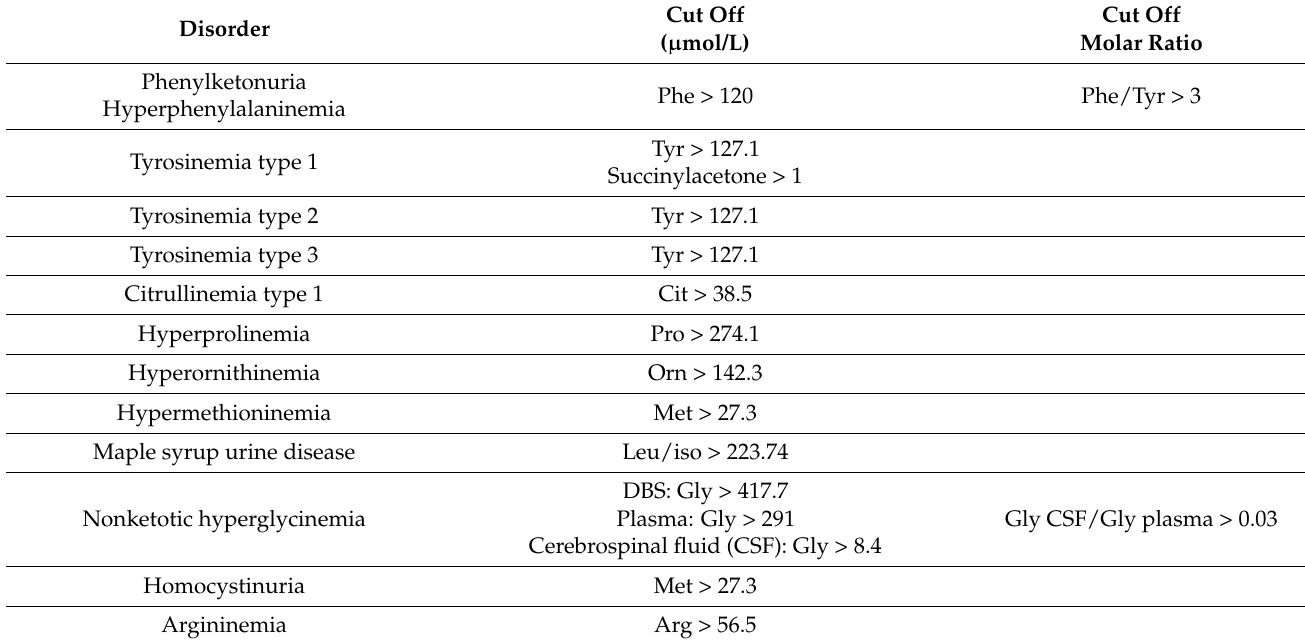
Table 1. Biomarker cut-offs for amino acid